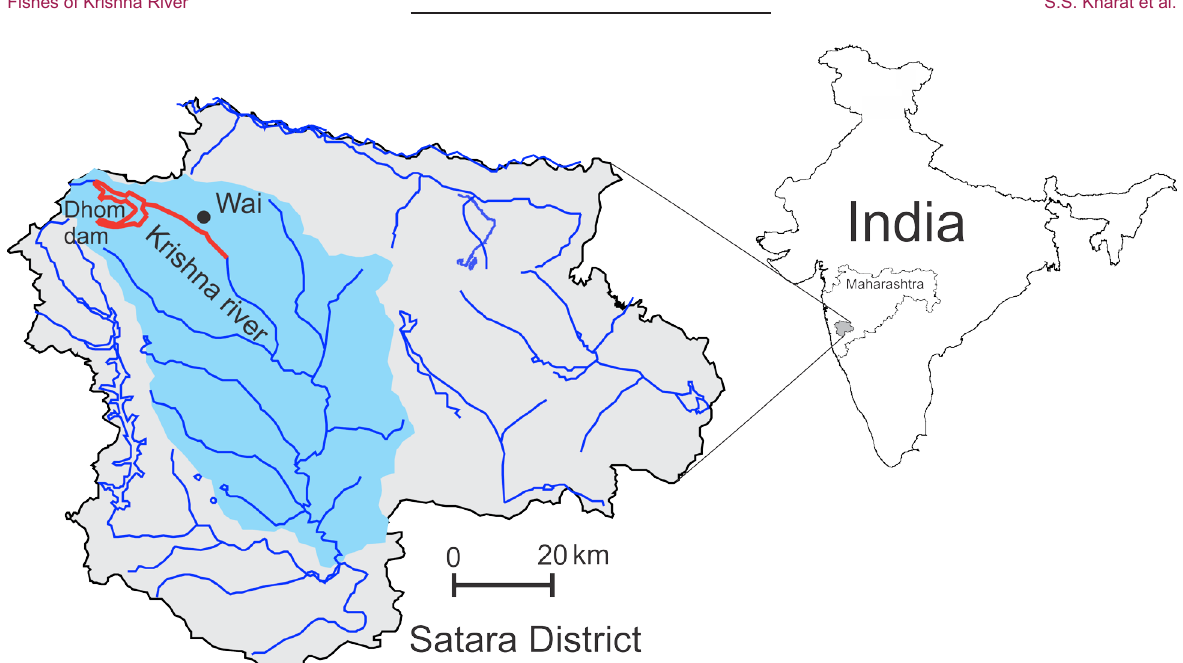
Image 1. Satara District is shown in grey. Sky blue area is the hydrobasin. Red line highlights the area considered for present